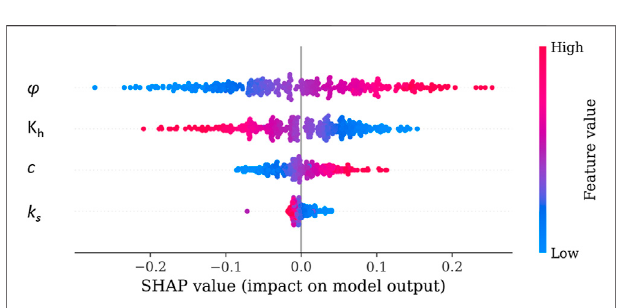
FIGURE 6 | SHAP values of features calculated from the CatBoost model.